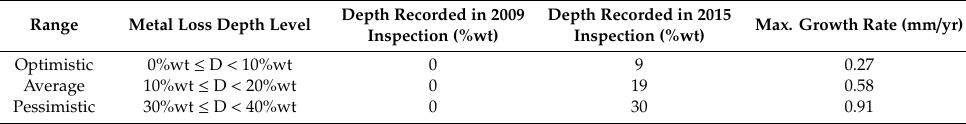
Table 3. Metal loss growth rate results.